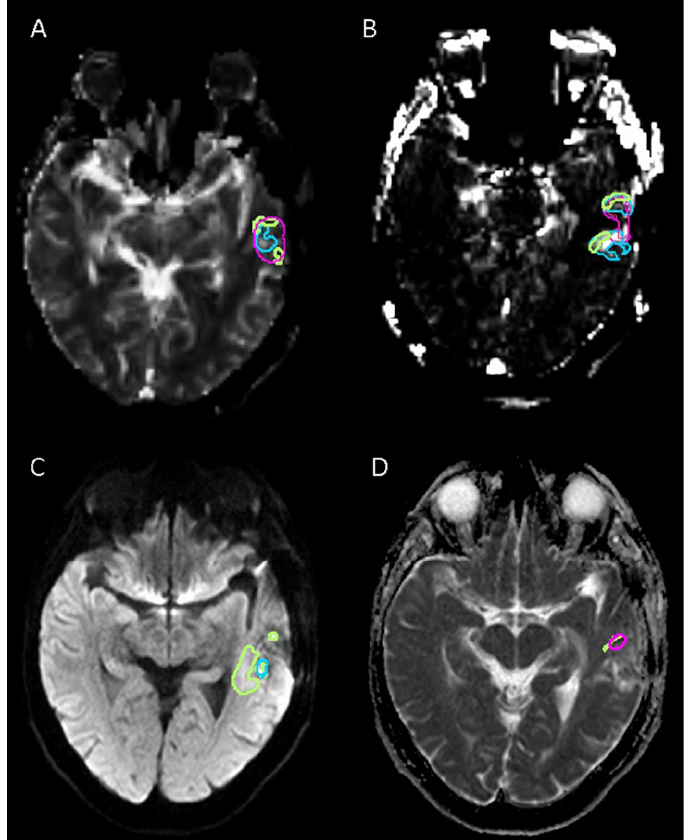
Figure 3. Example of sequences with poor agreement for tumor volume delineation in high-grade glioma between readers: ( A ) Relative cerebral blood volume (rCVB) corrected for contrast leakage shows. ( B ) Permeability estimation map (k2). ( C ) Diffusion-weighted imaging (DWI b1000). ( D ) Ap- parent diffusion coefficient (ADC) map. In this case, only two readers delineated tumor volume with an ADC map.